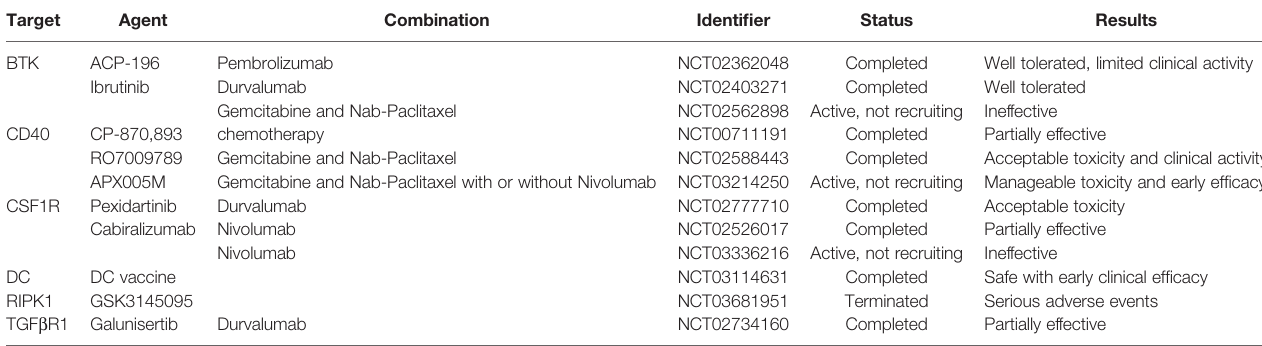
TABLE 2 | Past clinical trials targeting the microenvironment of PDA.